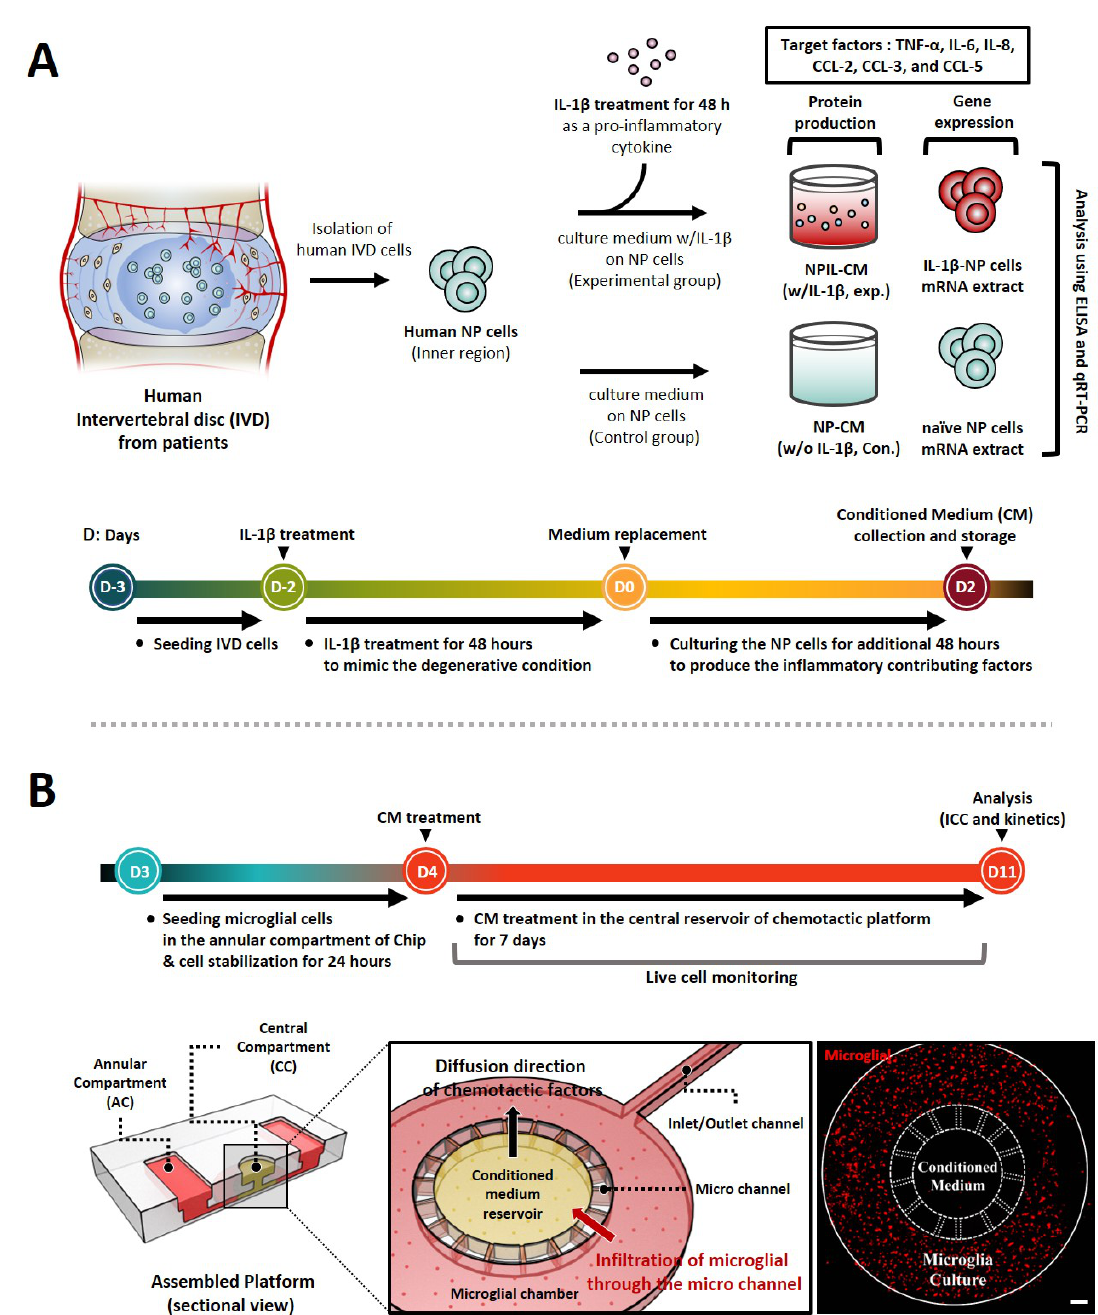
Figure 1. Schematic of stepwise experiment set-up and timeline for replication of interactions between human NP cells and microglia using a microfluidic chemotaxis platform. ( A ) Following initial injury, human NP cells are stimulated by pro-inflammatory cytokines IL-1 β , inducing the secretion of diverse inflammatory mediators and chemokines. Thus, we evaluated the protein production and gene expression of these factors, including TNF- α , IL-6, IL-8, and CCLs. ( B ) In the second phase, the degenerative microenvironment of human NP cells can permit the infiltration and activation of immune cells, such as microglia, which are believed to be responsible for neuro-inflammation. Thus, we assessed the microglia’s chemotaxis and its activation using a microfluidic chemotaxis platform. The platform is composed of two major units, including a central compartment (CC) and an annular compartment (AC), connected by thin microchannels. The fluorescence image shows the experiment set-up on the platform for the microglia chemotaxis study. Scale bar, 500 µ